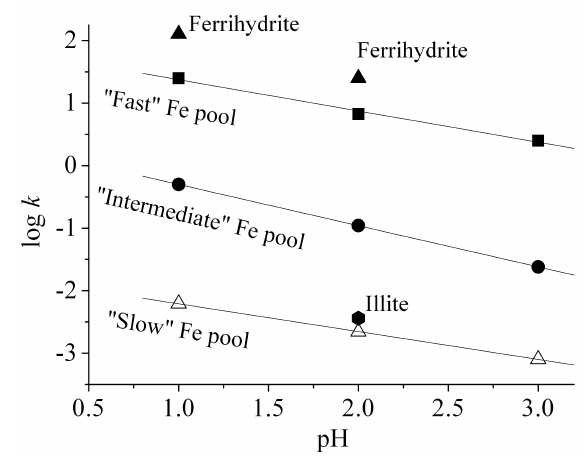
Fig. 5. Measured Fe dissolution curve with predicted curve of the Tibesti-PM 2 . 5 sample at pH 1 and at a dust/liquid ratio of 60mgL − 1 assuming a 3-Fe pool model. The inset shows the mea- sured Fe compared with the calculated Fe from the 3-Fe pool over the first 6 h of the experiments in more detail.